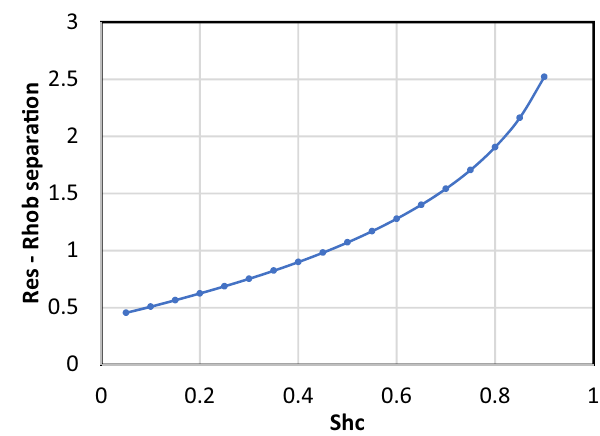
Fig. 16 S hc versus separation for